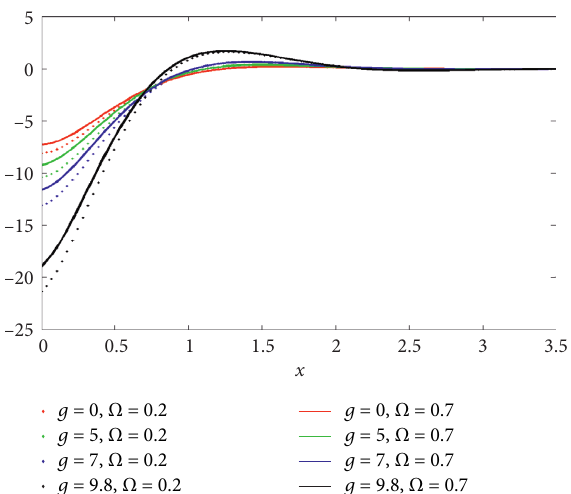
Figure 11: Vertical displacement w concerning x under gravity and rotation.